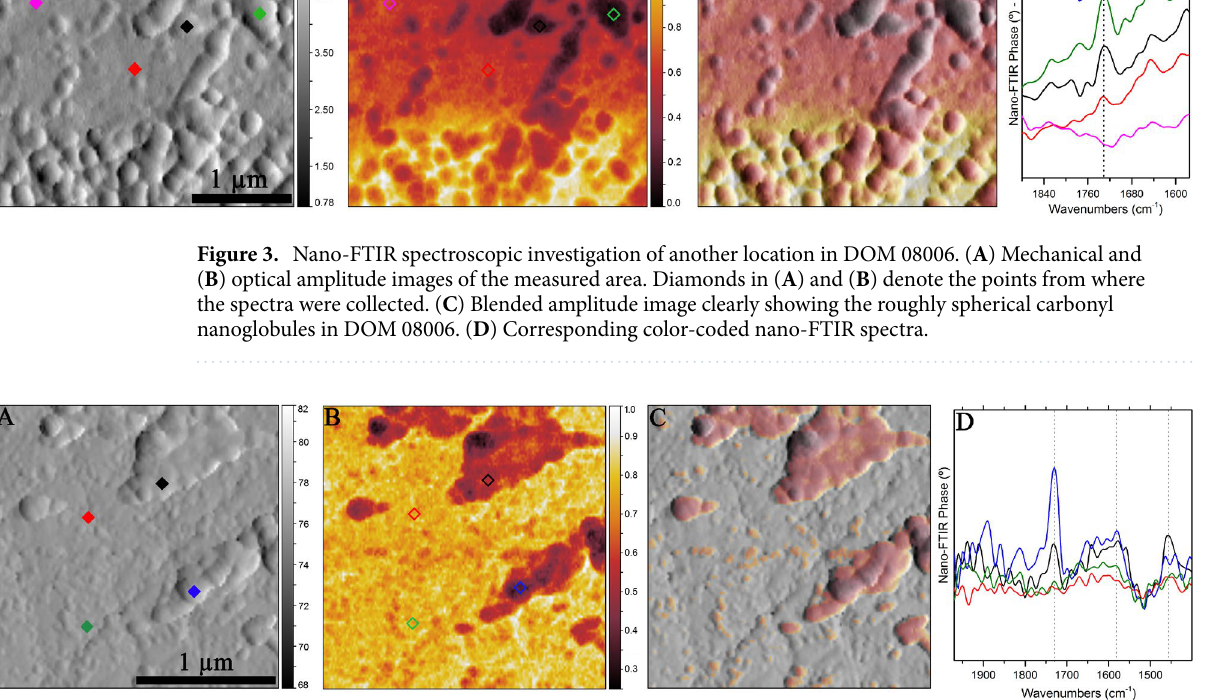
Figure 4. Nano-FTIR spectroscopic investigation of another location in DOM 08006. ( A ) Mechanical and ( B ) optical amplitude images of the measured area. Diamonds in ( A ) and ( B ) denote the points from where the spectra were collected. ( C ) Blended amplitude images indicating the boundaries and features of the organic compounds. ( D ) Comparison of the corresponding color-coded nano-FTIR